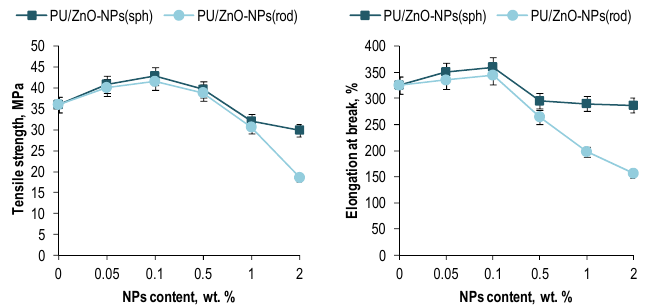
Figure 8. The mechanical properties of the polymeric membranes based on the PU/ZnO-NPs.